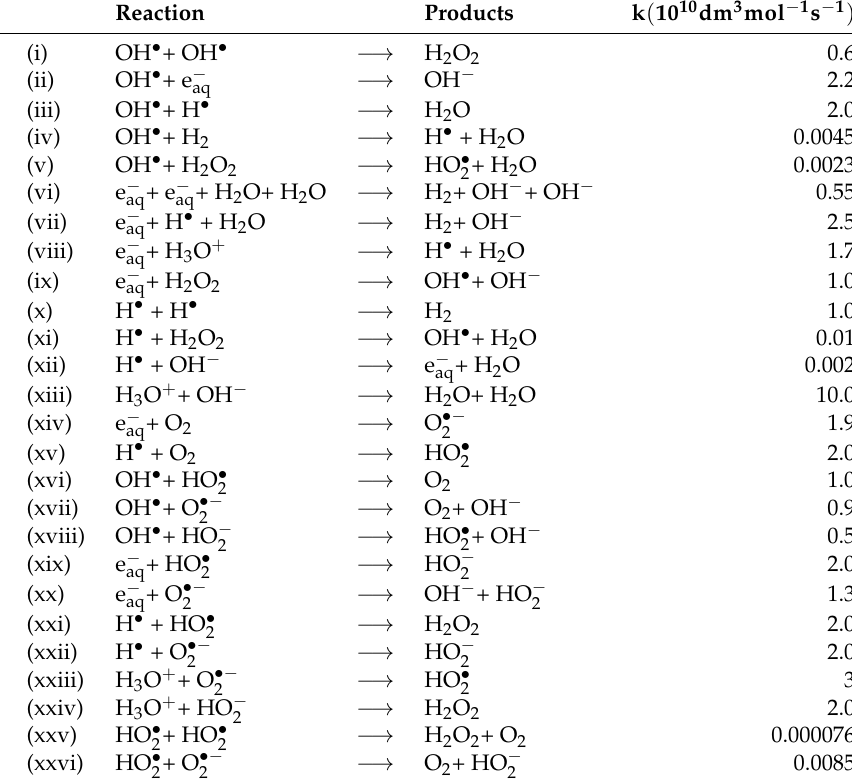
Table 1. List of all the reactions and reaction rate constants, k, used in this work (obtained mainly from [44]). Reactions (14)-(26) arise as a consequence of the presence of dissolved O 2 .